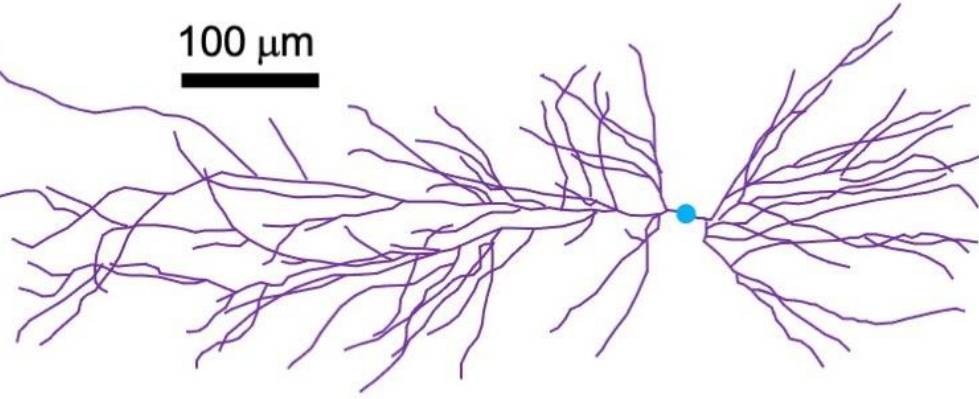
Figure 8. A hippocampal CA1 pyramidal cell used to model a neuron in the brain. The cell body is in blue and the dendrites are in purple. Adapted from Figure 2 of [37].